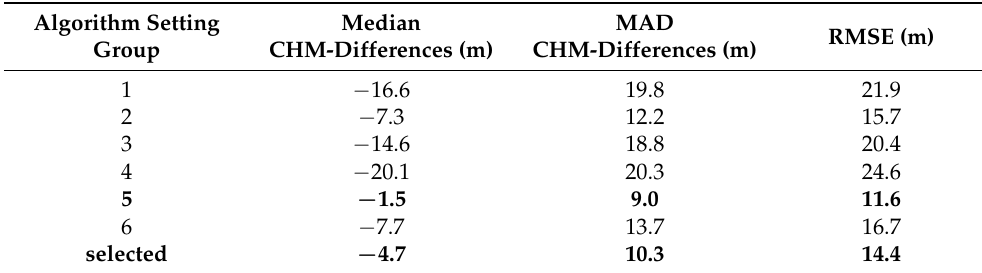
Table 3. Accuracy of GEDI-CHM estimates using rh_95 height metric derived with different algorithm setting groups.